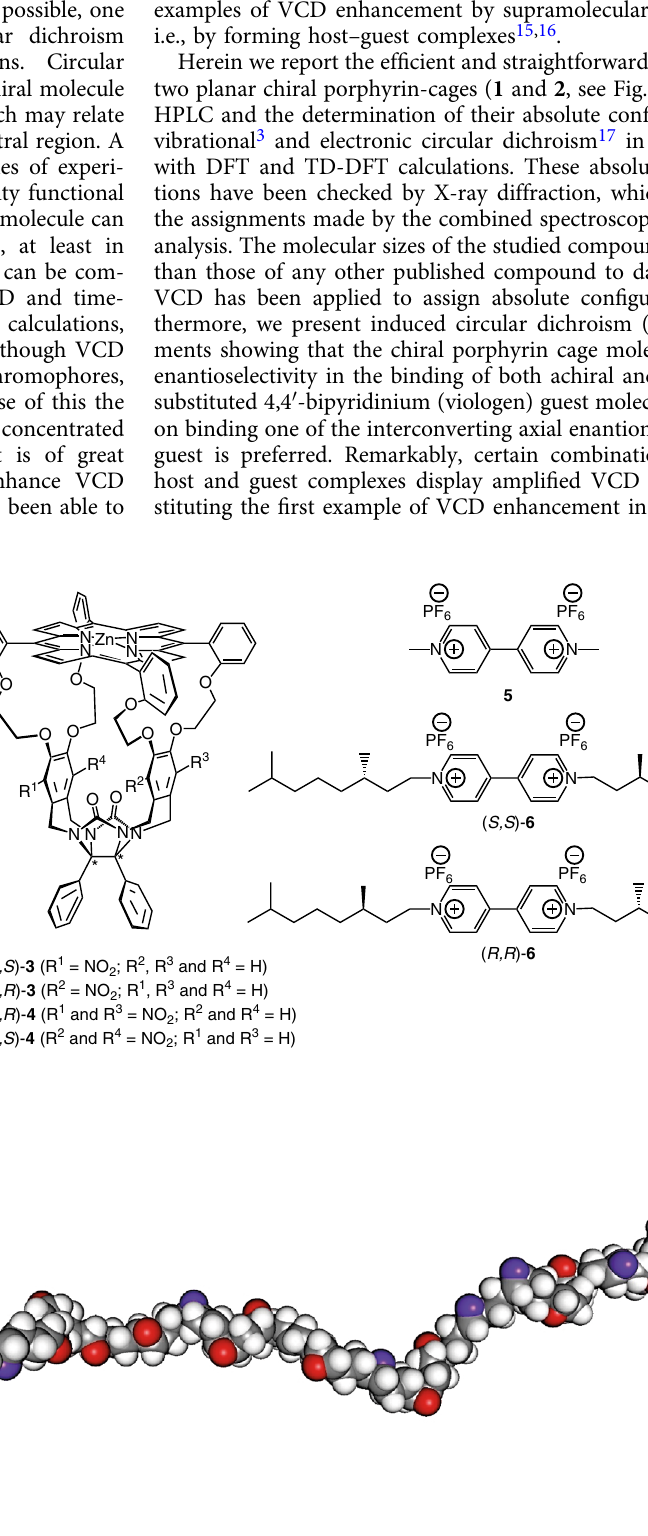
Fig. 1 Structure of compounds and writing of chemical information. a Molecular structures of hosts and guests: chiral porphyrin-cages 1 - 4 and achiral and chiral viologen guests 5 and 6 . b Schematic representation of a chiral manganese porphyrin cage catalyst (green) provided with a 4- tert -butylpyridine ligand (blue) gliding along a chiral polymer chain (e.g. polybutadiene), while converting the polymer double bonds into chiral epoxide functions (red and purple), see